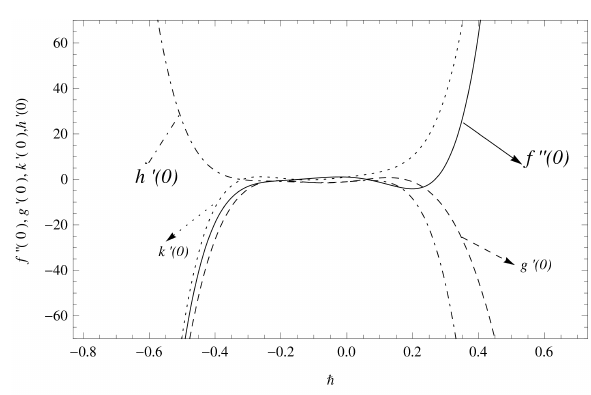
Fig. 25: Comparison of Wang [9] and HAM solution for velocity func- tion h ( η )